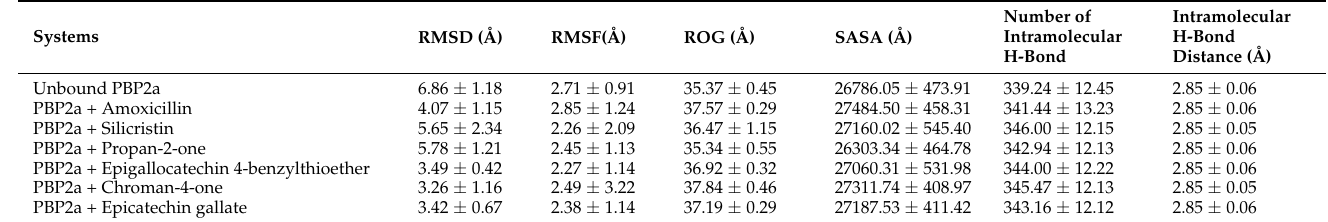
Figure 5. Comparative root-mean-squared deviation (RMSD) plots of alpha-carbon, the top-five pheno- lics, and amoxicillin against the active site of PBP2a of S. aureus over a 120 ns MD simulation period. Table 3. Average RMSD, ROG, RMSF, SASA, and intramolecular-hydrogen-bond number and distance values of the top-five phenolics following a 120 ns simulation at the active site of PBP2a of S. aureus